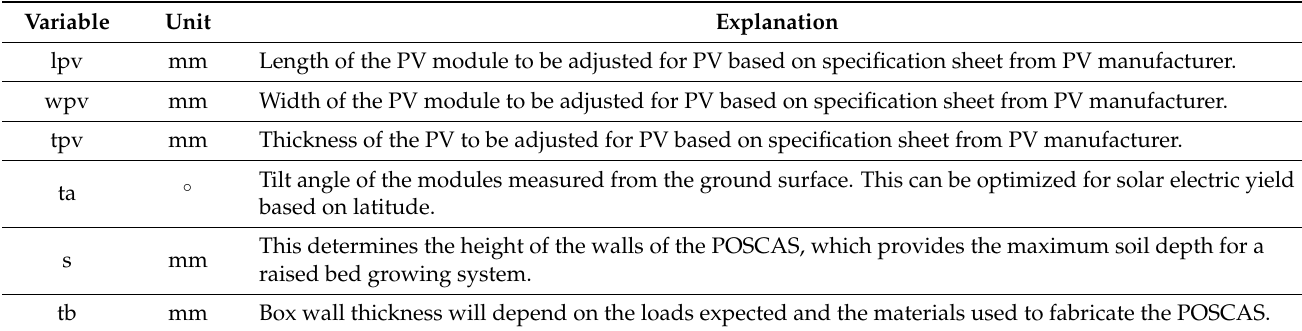
Figure 3. Basic POSCAS design with semitransparent PV, a 10-degree tilt angle, and a box depth of 1m shown with the automatic customizer in OpenSCAD. Table 2. Primary POSCAS variables in OpenSCAD that determine 3-D printable box